Question: Give a one-sentence summary of this figure.
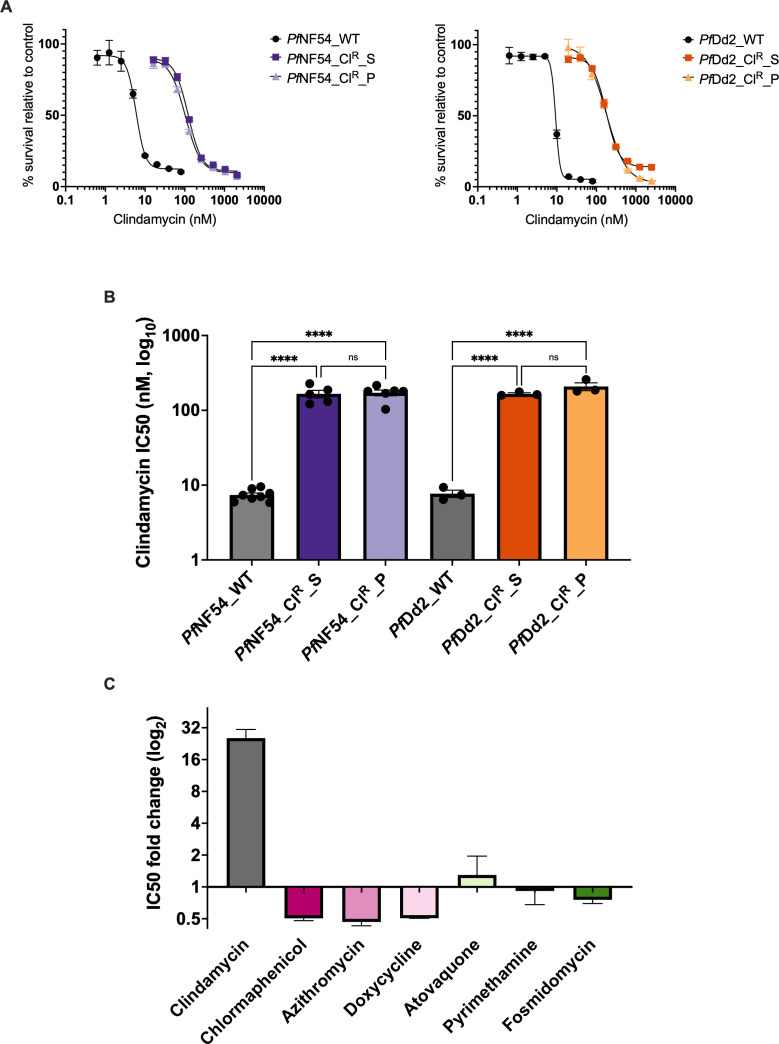
Answer: Asexual and sexual growth of Pf NF54 and Pf Dd2 clindamycin-resistant parasites. ( A ) Representative clindamycin dose-response curves of Pf NF54_Cl R _S/ P and Pf Dd2_Cl R _S/ P relative to a no-drug control. Pf NF54 clindamycin drug assays were performed over 144 h, while Pf Dd2 assays were performed over 168 h. Error bars represent the standard deviation. ( B ) Comparison of growth inhibition (IC50) among NF54 parasite lines ( Pf NF54_Cl R _S [ n = 5], Pf NF54_Cl R _P [ n = 6], and Pf NF54_WT [ n = 8]) and Dd2 parasite lines ( Pf Dd2_Cl R _S [ n = 3], Pf Dd2_Cl R _P [ n = 3], and Pf Dd2_WT [ n = 3]) across “ n ” biological replicates. Statistical significance was determined by one-way ANOVA (****=P ≤.0001). Error bars represent the mean ± SEM. ( C ) IC50 fold change of Pf NF54_Cl R _S from control parasites to apicoplast and non-apicoplast translational inhibitors from five independent experiments for clindamycin and two independent experiments for remaining antimalarials. Error bars represent the geometric mean with geometric SD.